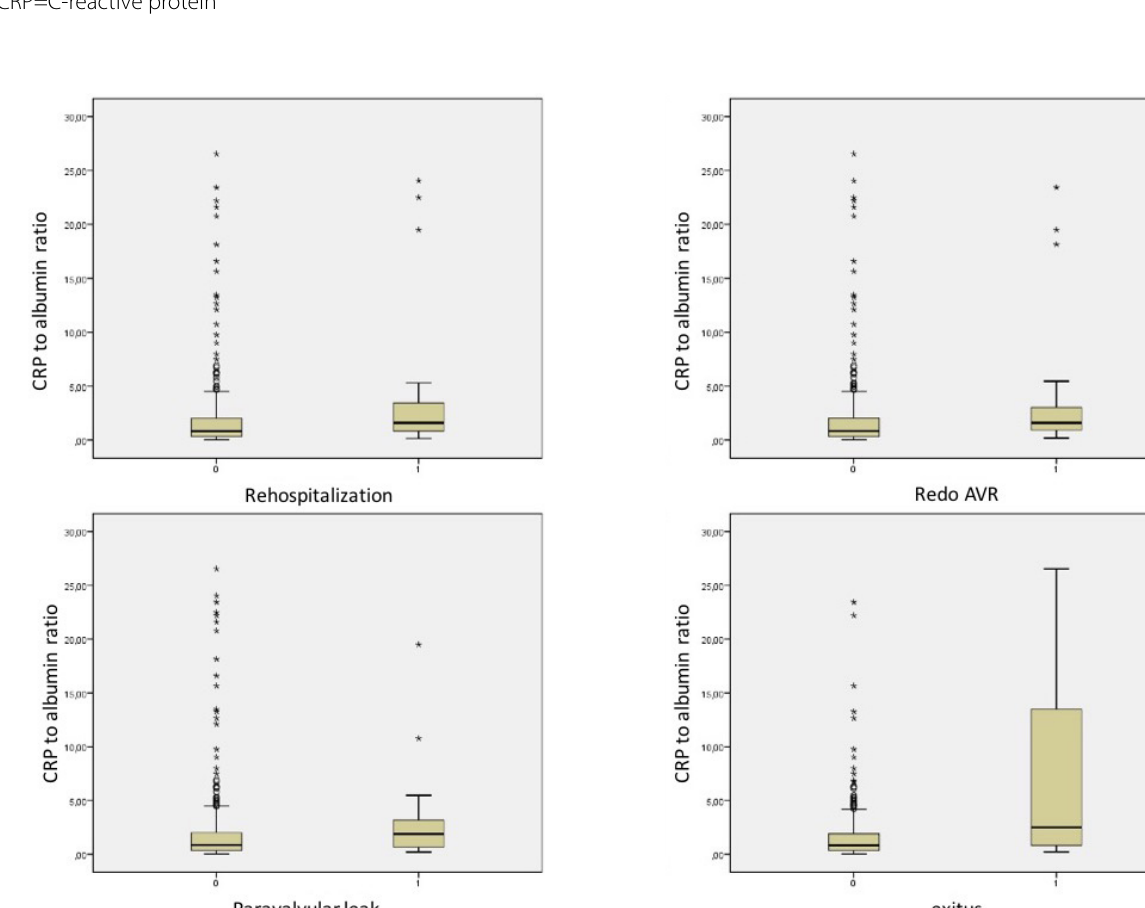
Fig. 1 – Comparison of serum CRP to albumin ratio in the whole study group according to rehospitalization, aortic reoperation, paravalvular leakage, and mortality